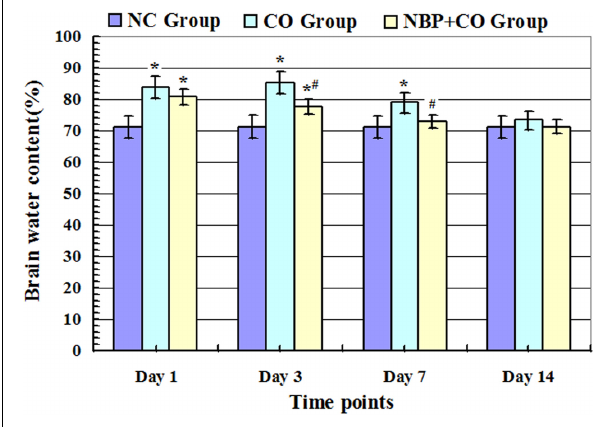
FIGURE 2 | Alterations of brain water content in NC, CO, and NBP + CO groups. Brain water content in CO group was increased gradually on day 1 after exposure to CO, peaked on day 3 and then slightly decreased, yet it still exhibited a high level on day 7, and there were statistically differences in brain water content between day 1 and day 7 compared with that in normal control group ( n = 4, P < 0.05). In the meantime, brain water content in NBP + CO group was also lower than that in CO group ( n = 4, P < 0.05). ∗ Compared with NC group, P < 0.05; # compared with CO group at the same time point, P < 0.05 ( F = 13.261 ∼